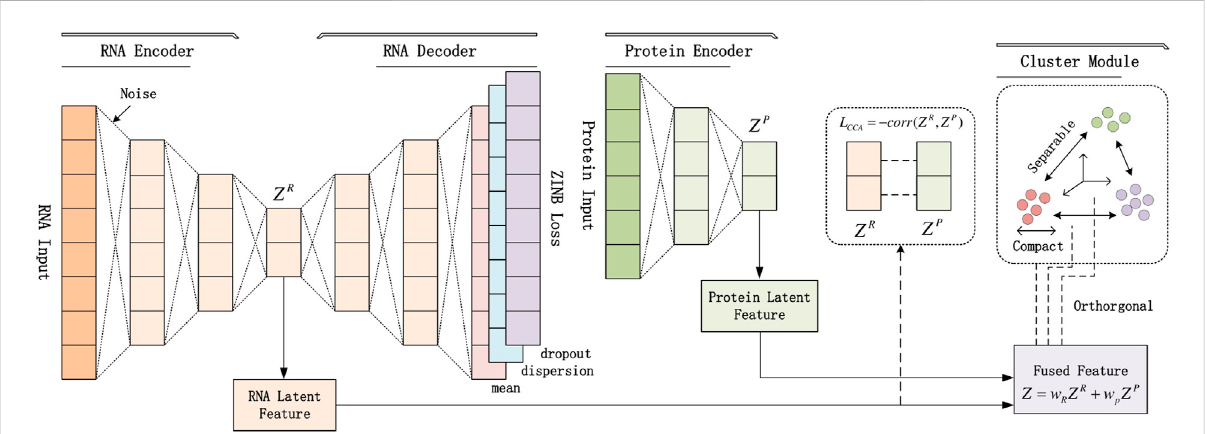
FIGURE 1 Structure ofthescCTClust model:(1)preprocessedmultiomicsdataareusedasinputofomics-speci fi cencodersseparately;outputsarelatent features and estimated posterior parameters of the ZINB or NB model. (2) A fusion layer is introduced to linearly fuse the latent features of different omics data. (2) A CCA loss is introduced to fi nd the maximumly correlated omics latent representations. (4) A Cauchy – Schwatz divergence-based clustering module is added after the fusion